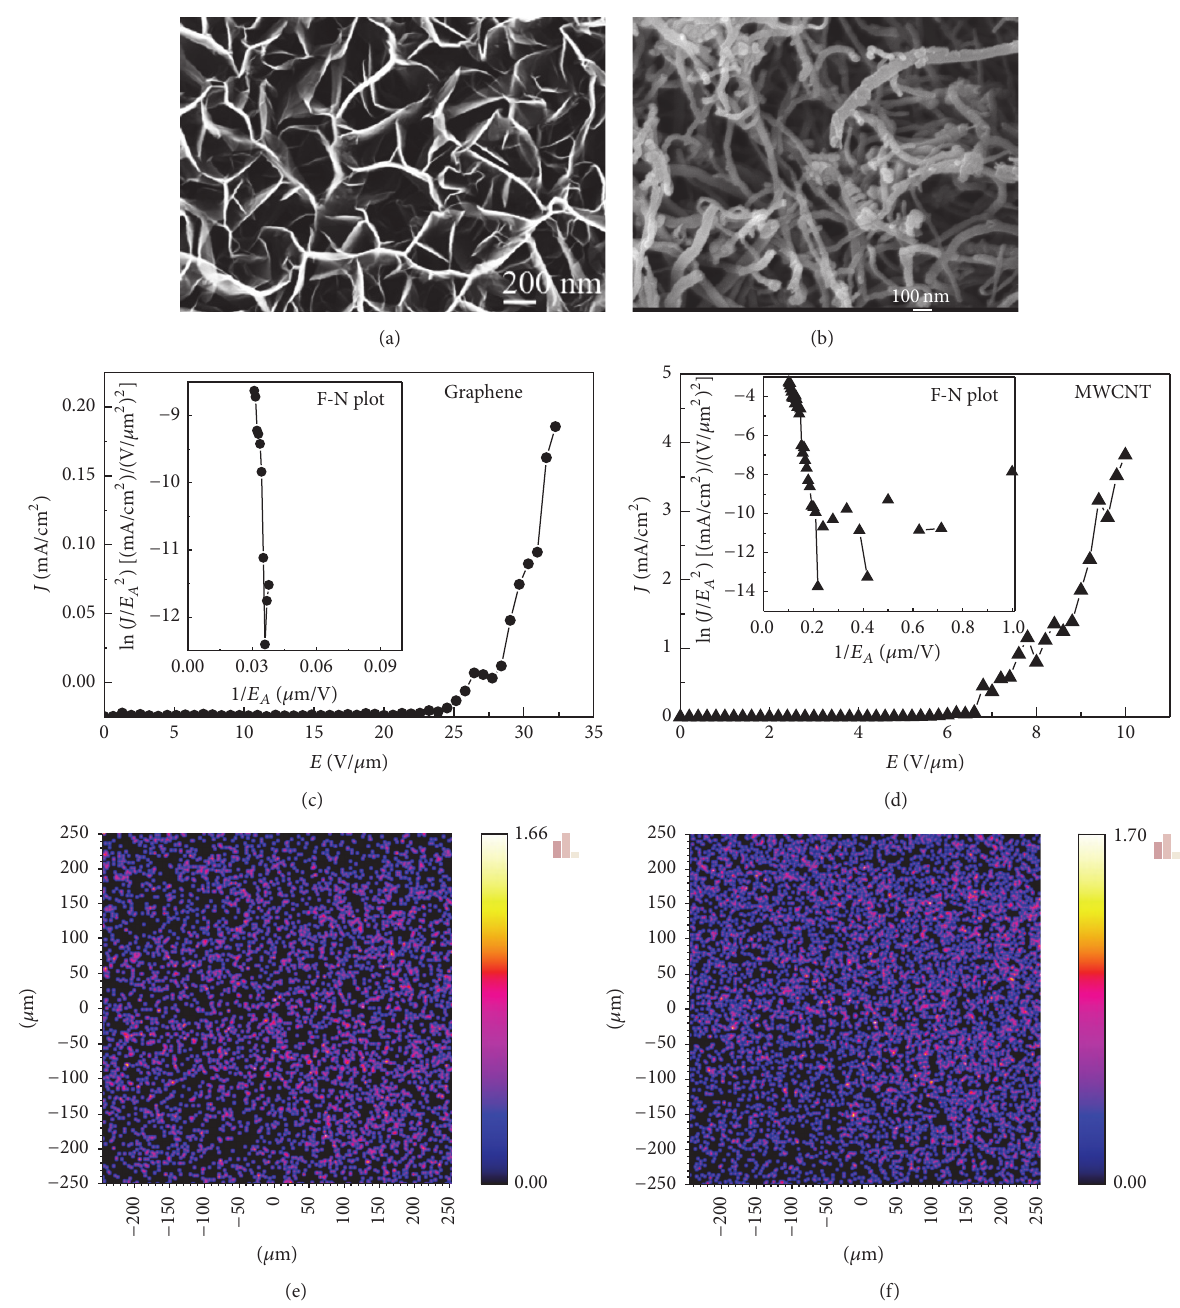
Figure 1: Scanning electron microscopy of (a) FLG, (b) MWCNTs, and electron field emission (EFE) of (c) FLG and (d) MWCNTs. XPS image of (e) graphene and (f) MWCNT [ red particles are carbon and blue particles are oxygen in both cases ] obtained when kinetic energy is 1202.00 eV (C 1s) and 954.14 eV (O 1s),